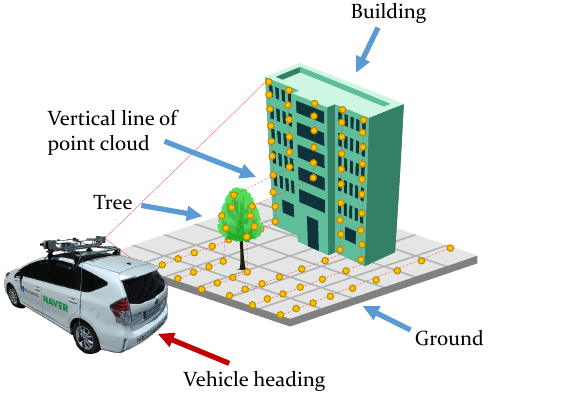
Figure 4. Shape file representations for building and contour. An example of polygon data type structure is in ( a ), and an example of contour map is in ( b ). ( c ) is sample shape-map (building) in the campus data. ( d ) is sample shape-map (DEM) in the campus data.